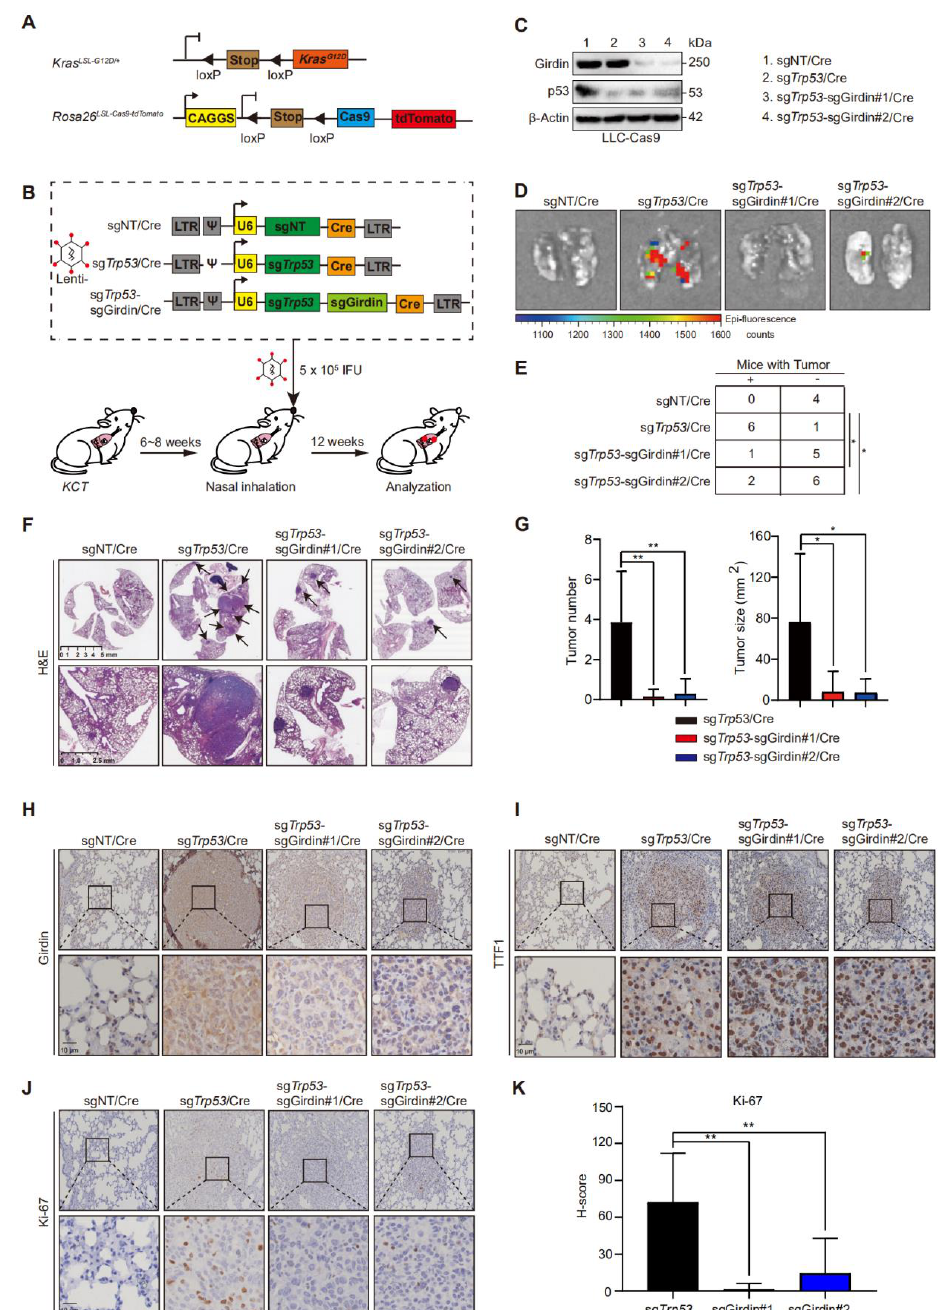
Figure 1. Girdin knockout significantly suppresses autochthonous tumorigenesis in LUAD. ( A ) Schematic of the Kras LSL-G12D/+ allele and Rosa26 LSL-Cas9-tdTomato double knockin in a genetically engineered mouse model (GEMM). ( B ) Lung tumors were initiated in the KCT mice and allowed to develop for 12 weeks after intranasal administration or Lenti-sgNT/Cre of Lenti-sgRNAs/Cre. ( C ) Western blot (WB) evaluation of the knockdown efficiency of p53 and Girdin sgRNAs in LLC-Cas9 cells. ( D ) Representative living images of tumor-bearing lungs from KCT mice induced (by inhalation) with diverse lentivirus. Excitation maximum: 554 nm; emission maximum: 581 nm. ( E ) Contingency tables demonstrating the number of tumor-bearing mice. (Two-sided Fisher’s exact test, * p < 0.05). ( F ) Representative hematoxylin and eosin (H&E) staining of serial sections from lung tumor mice 12 weeks post-intranasal infection (scale bars 5 mm and 1.25 mm). ( G ) Quantification of tumor number ( left ) and size ( right ) per mouse for KCT mice 12 weeks post-Lenti-sgNT/Cre or